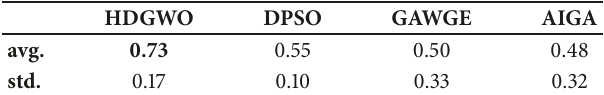
Figure 8: The MPIs of the HDGWO, the DPSO, the GAWGE, and the AIGA. Table 7: The avg. and the std. of the MPI for the HDGWO, the DPSO, the GAWGE, and the